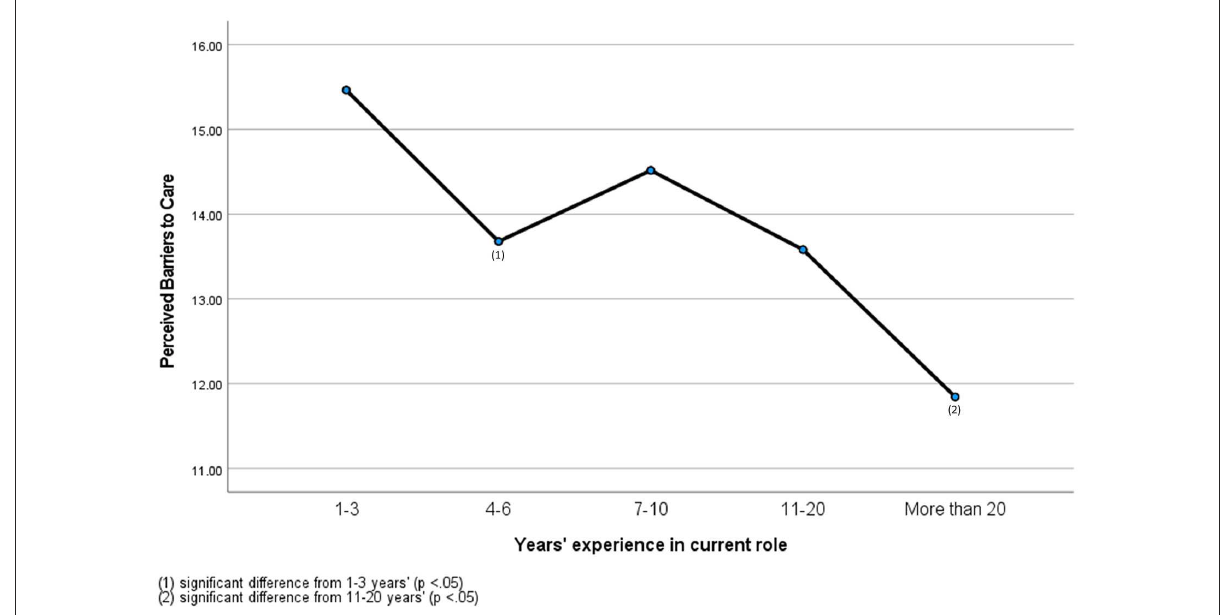
FIGURE1 Perceived barriers of veterinary professionals with different years’ experience.